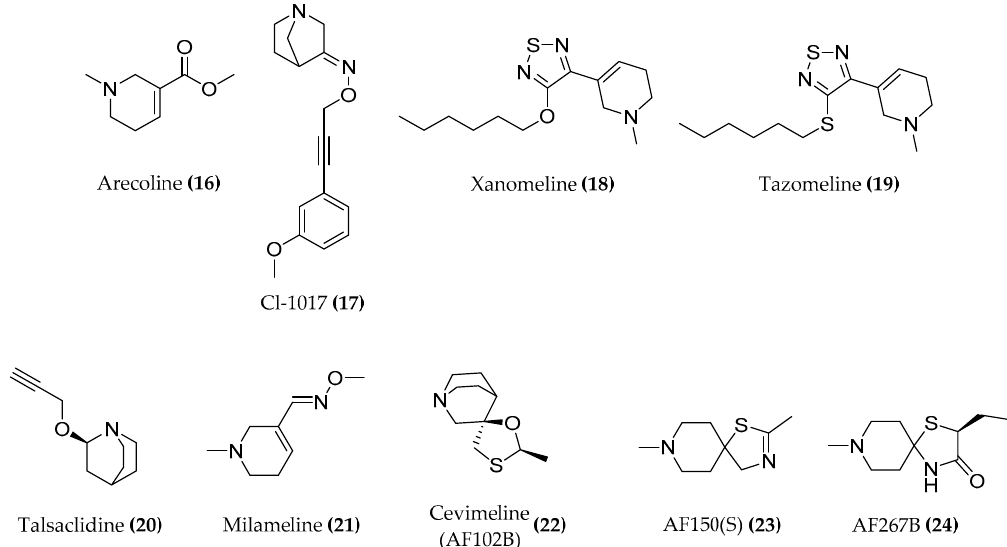
Figure 9. Structures of moderately active and selective orthosteric M1 agonists.